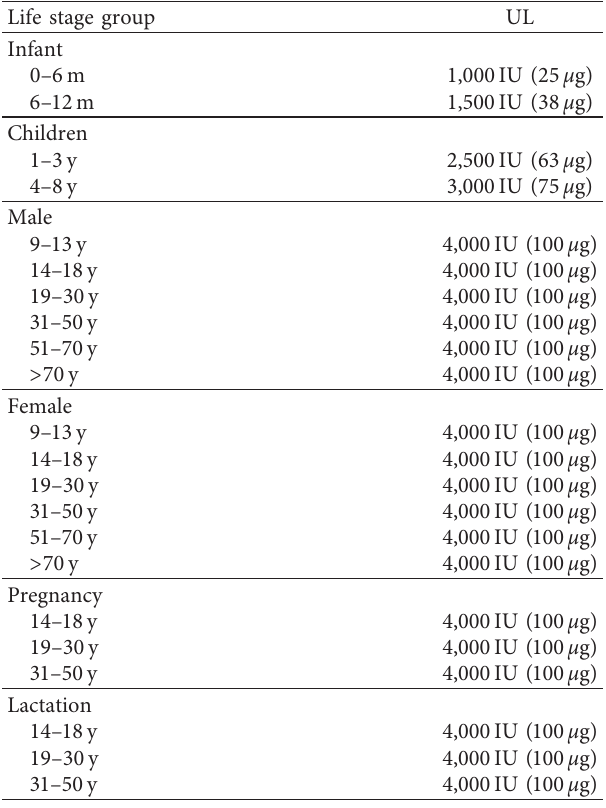
Table 1: Daily upper limit for vitamin D supplementation (adapted from dietary reference intakes for calcium and vitamin D